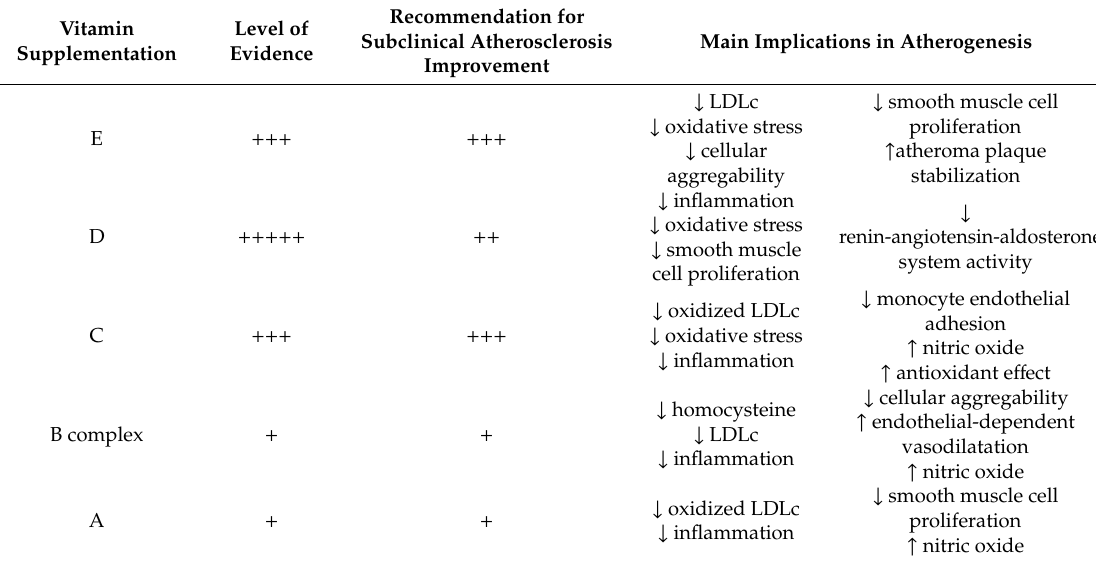
Table 5. Summary table for vitamin supplementation e ff ect on subclinical atherosclerosis in subjects without